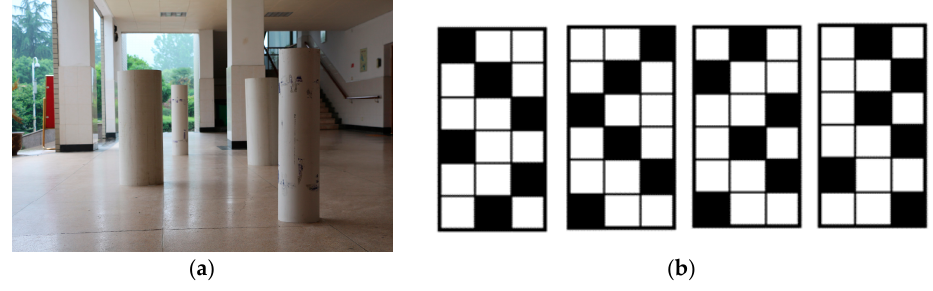
Figure 15. Obstacle arrangements. ( a ) An image of obstacle arrangement; ( b ) Four other obstacle arrangements. Table 3. Number of collisions and time to complete tests in two conditions: the audio interface transferred to the VIP is generated according to original ground detection or traversable area expansion. Detection Result Transfered to VIP Original ground deteciton